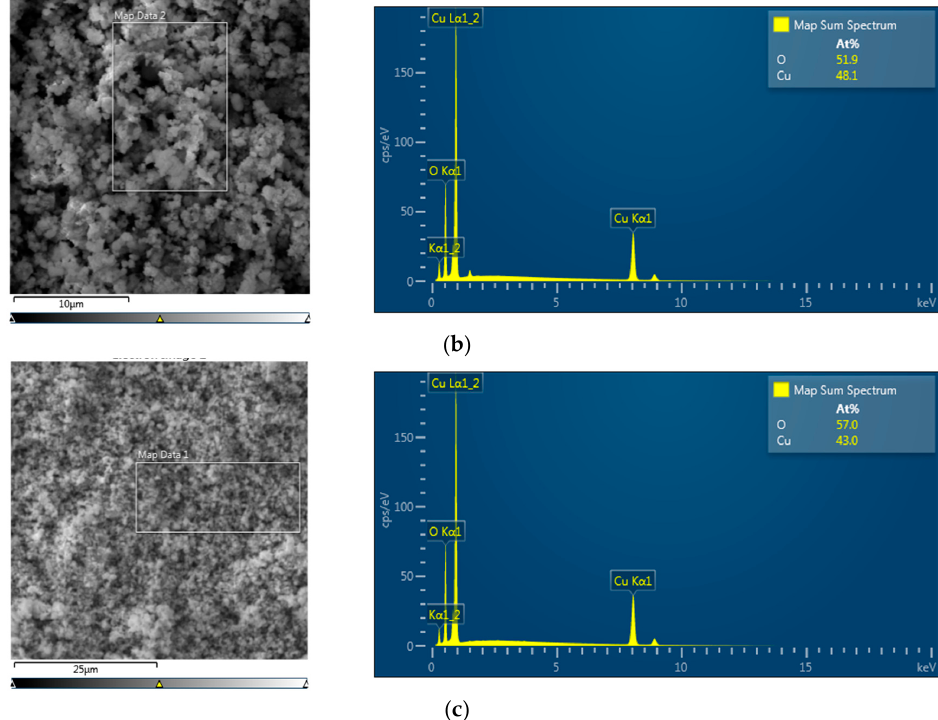
Figure 2. EDS images of carbon-coated NPs immobilized onto LLDPE: ( a ) CuNPs; ( b ) Cu 2 ONPs; ( c ) CuONPs.